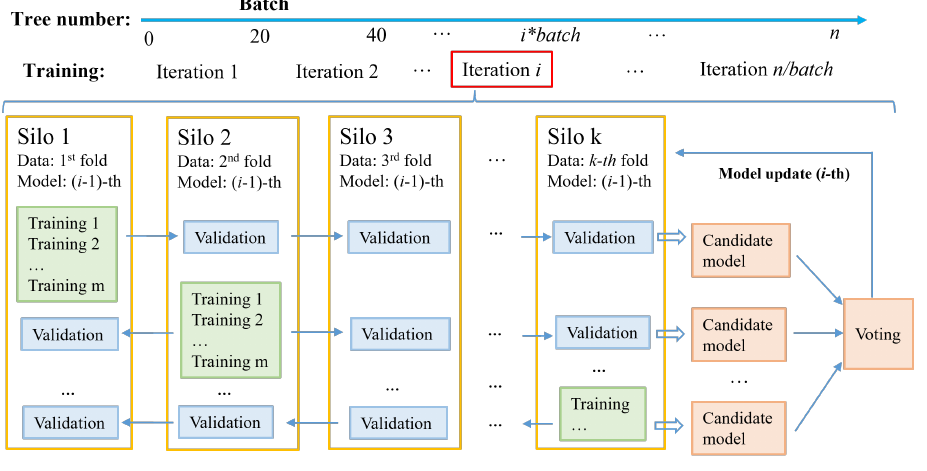
Figure 4. The construction process of